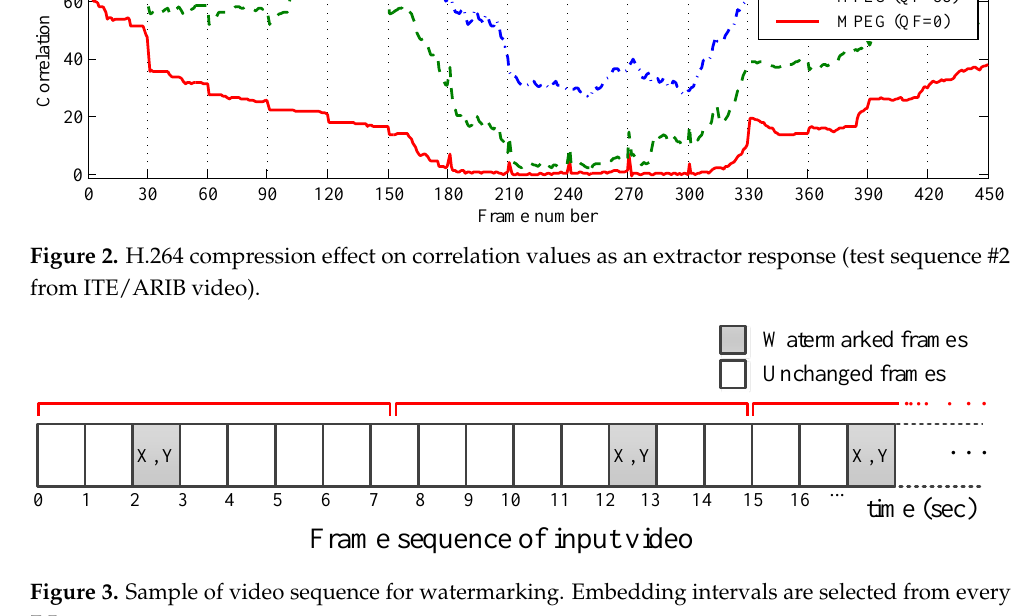
Figure 3. Sample of video sequence for watermarking. Embedding intervals are selected from every 7.5